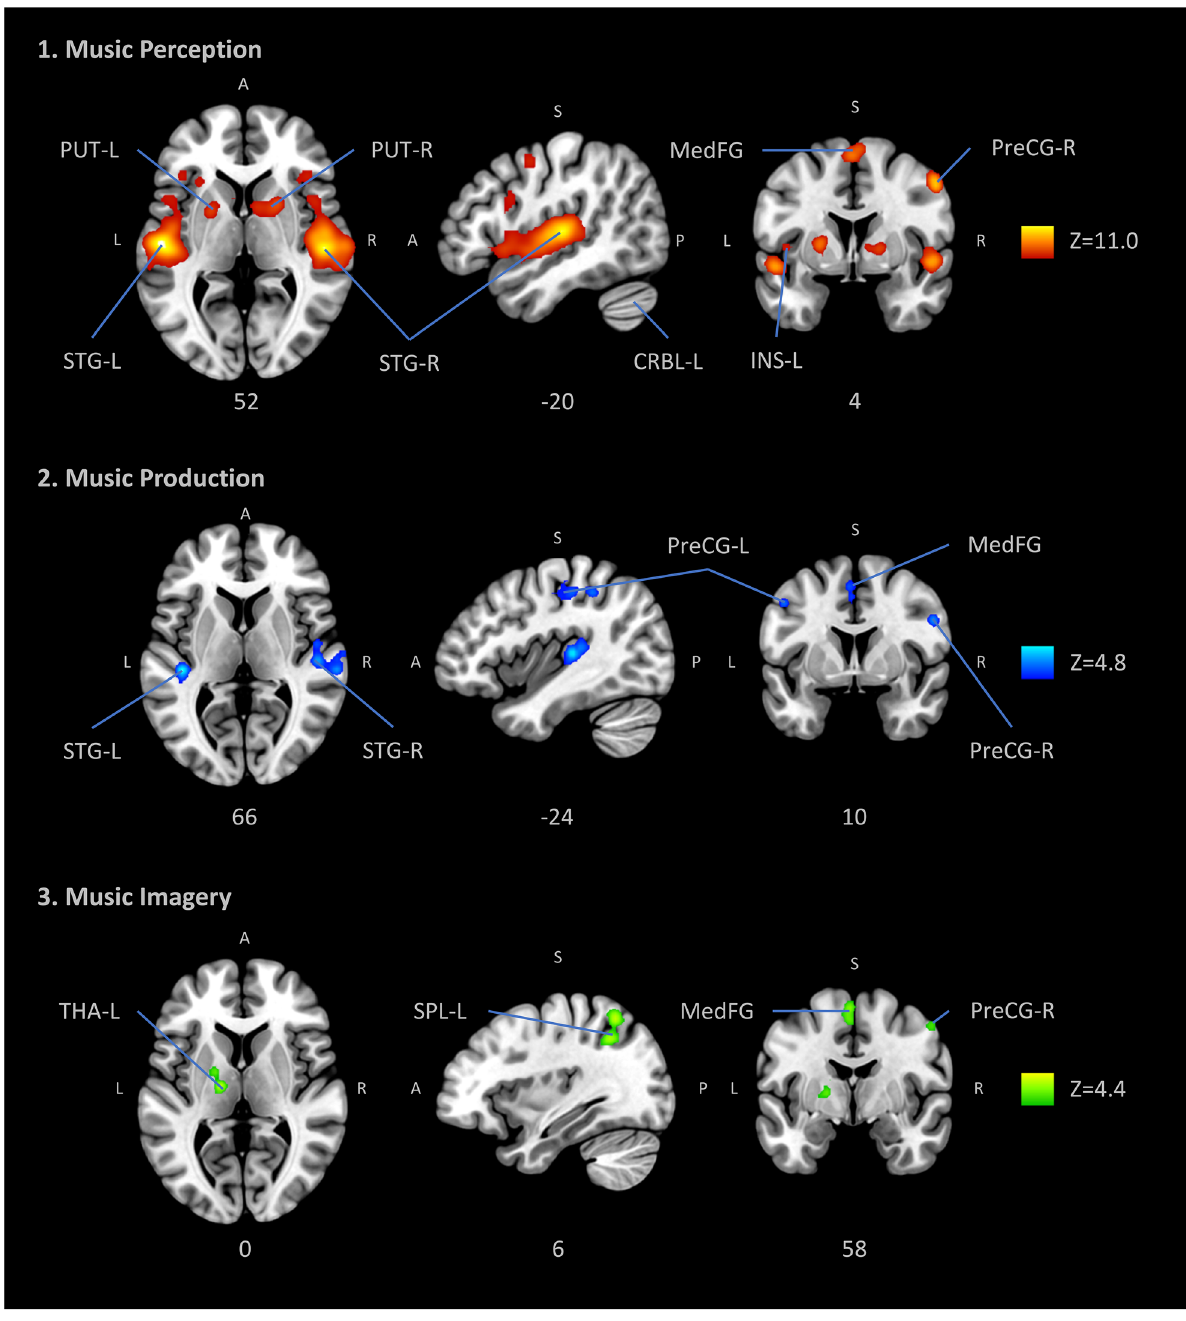
Figure 1. Anatomic likelihood estimation meta-analytic results for studies of music perception, production and imagery, at cluster level inference p < 0.05 (FWE). The primary outcomes included ALE meta-analyses of music perception, music production, and music imagery, independently. ROIs: CRBL cerebellum, INS insula, MedFG medial frontal gyrus, PreCG precentral gyrus (primary motor cortex or M1), PUT putamen, SPL superior parietal lobule, STG superior temporal gyrus (primary auditory cortex), THA thalamus, L left, R right, Z peak Z-value. Figure created with Mango (http:// rii. uthsc sa. edu/ mango// userg uide.